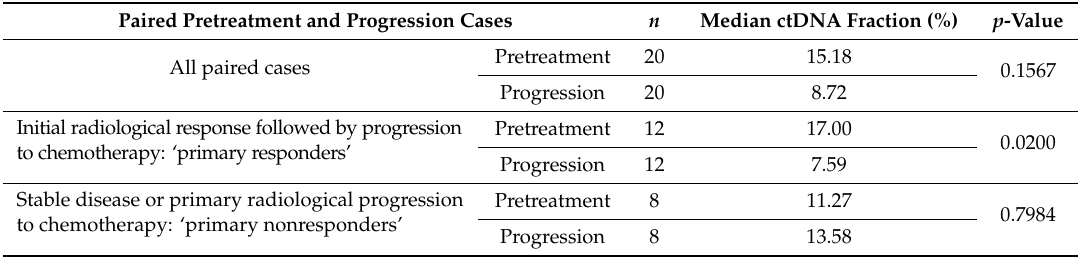
Table 3. Comparison of ichorCNA estimated ctDNA fraction at pretreatment and progression of first line chemotherapy ( p -values Mann–Whitney